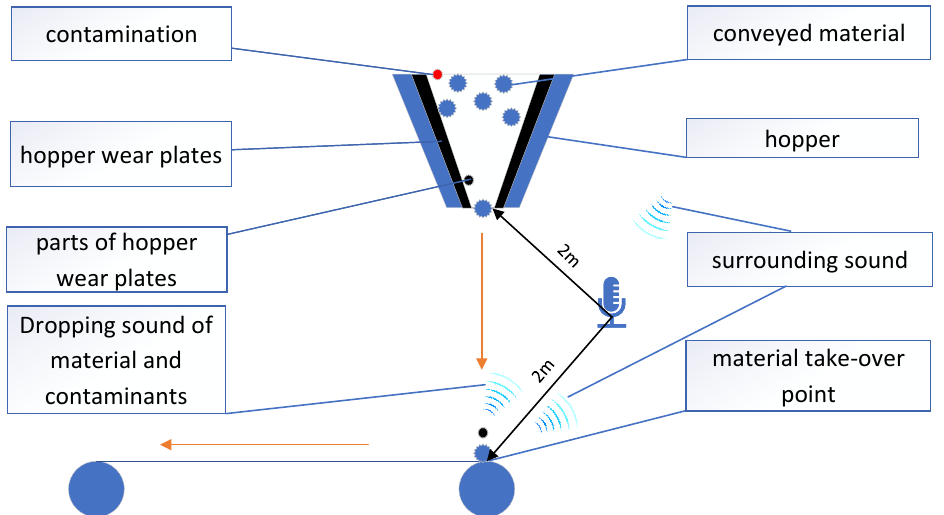
Figure 1. Measurement setup consisting of conveyor belt and material hopper (distances are colored in black, material flow in